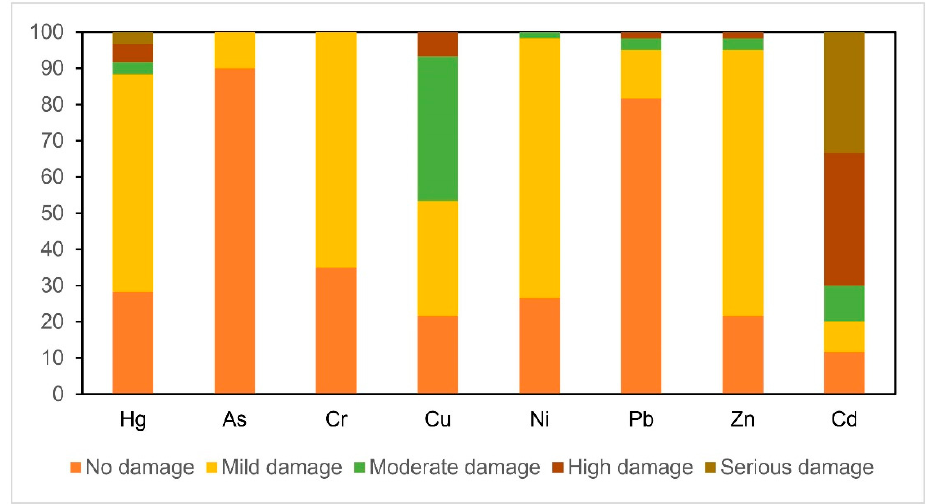
Figure 3. The ratio of the number of different pollution levels of single pollution index to the total number of samples number of samples (%).